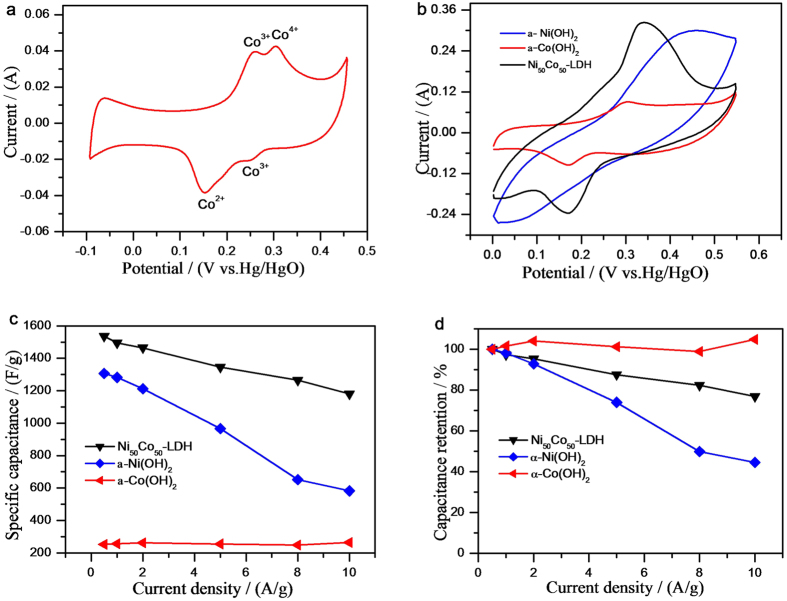
CV curve of (a) α-Co(OH)2 at 10 mV s−1 and (b) the Ni50Co50-LDH, α-Ni(OH)2 and α-Co(OH)2 at 100 mV s−1. The (c) compared specific capacitance and (d) the capacitance retention for Ni50Co50-LDH, α-Co(OH)2 and α-Ni(OH)2.